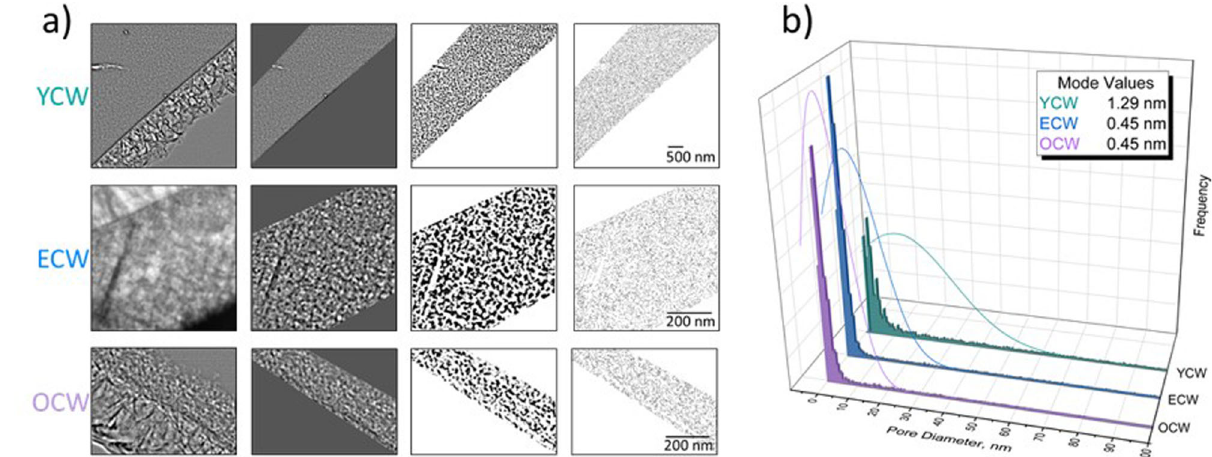
Fig. 3 Gel layer porosity data acquired from transmission electron microscopy images of CaZn28 exposed to synthetic cement solutions. Showing ( a ) the imaging processing steps required to acquire average pore diameter measurements (PDD), where pores are in white; and ( b ) the resulting histogram of the data obtained, listing the mode